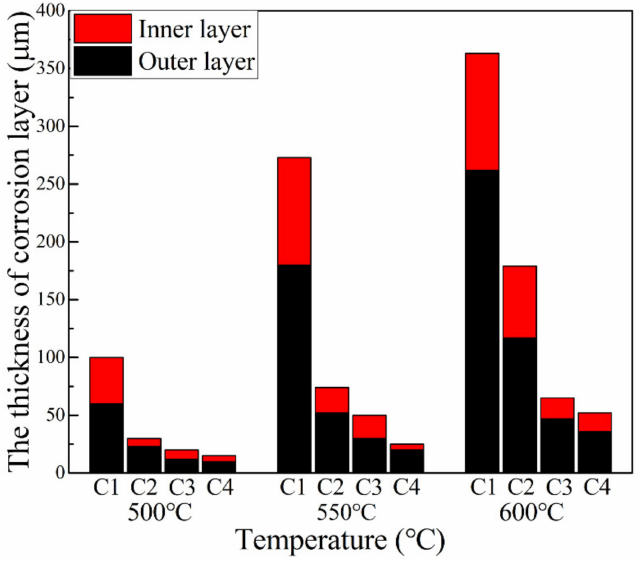
Figure 16. Bar diagram of thickness variation of outer, inner, and total corrosion